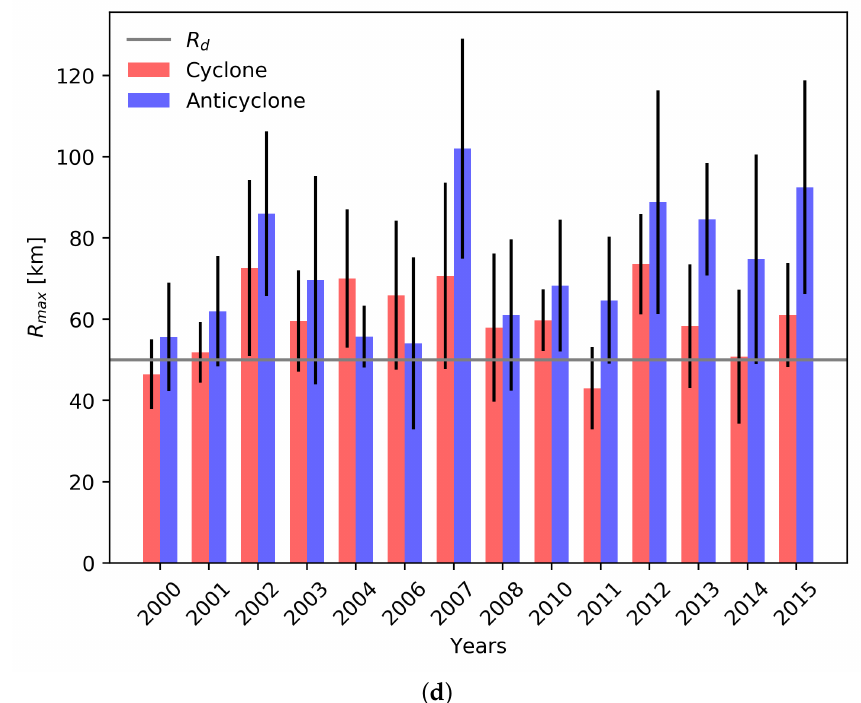
Figure 8. 2D (surface) statistics for both eddies of the Ras al Hadd dipole with error bars (vertical segments at the end of the colored lines): ( a ) Maximal azimuthal velocity V max , ( b ) steepness of the radial profile of azimuthal velocity, ( c ) dynamical Rossby number Ro , and ( d ) radius of maximal velocity R max . The horizontal gray line in the steepness plot indicates a Gaussian profile of velocity and the horizontal gray line in the R max plot indicates the value of the internal Rossby radius of